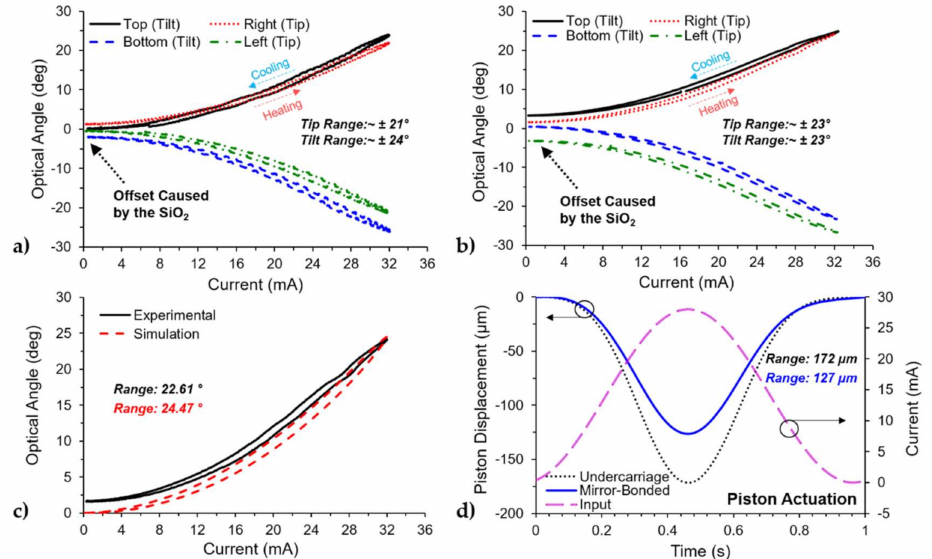
Figure 7. Measured AC steady-state performance (1 Hz) of both the undercarriage and the mirror- bonded device: ( a ) Tip/tilt motion for the undercarriage device, ( b ) tip/tilt motion for the mirror- bonded device, ( c ) comparison of the tip/tilt motion between experimental and simulation results of the mirror-bonded device, ( d ) piston motion for both